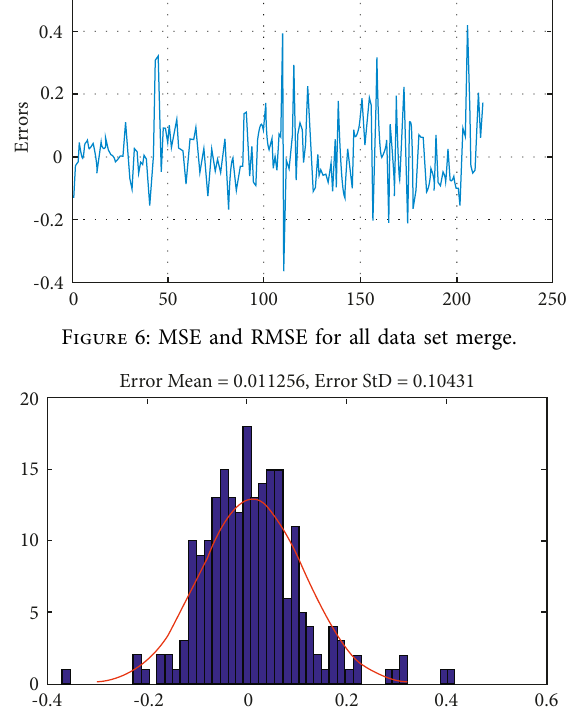
Figure 7: All data set mean error.